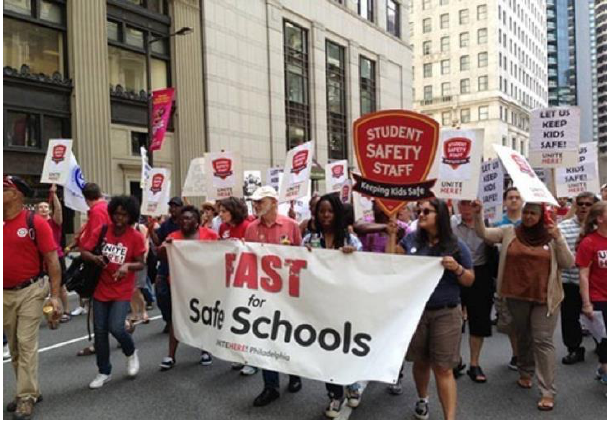
FIGURE 5: PHILADELPHIA WORKERS MARCH IN SUPPORT OF SCHOOL SAFETY STAFF. IMAGE COURTESY OF UNITE HERE LOCAL